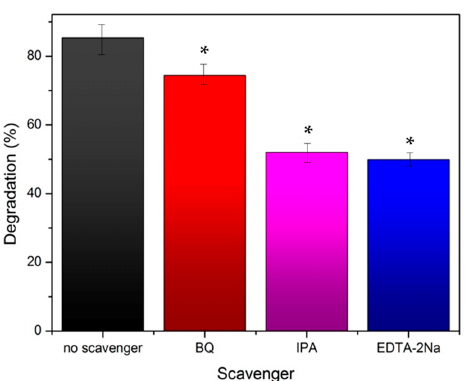
Figure 14. Percentage of degradation of rhodamine B by Ag-TiO 2 nanoparticles (in black) and also in the presence of scavengers: ethylenediaminetetraacetic acid disodium salt (EDTA-2Na) (in blue), benzoquinone (BQ) (in red) and isopropanol (IPA) (in purple). The data represent means ± standard deviation from three experiments. In these series of experiments, * p < 0.05 was considered statisti- cally significant.